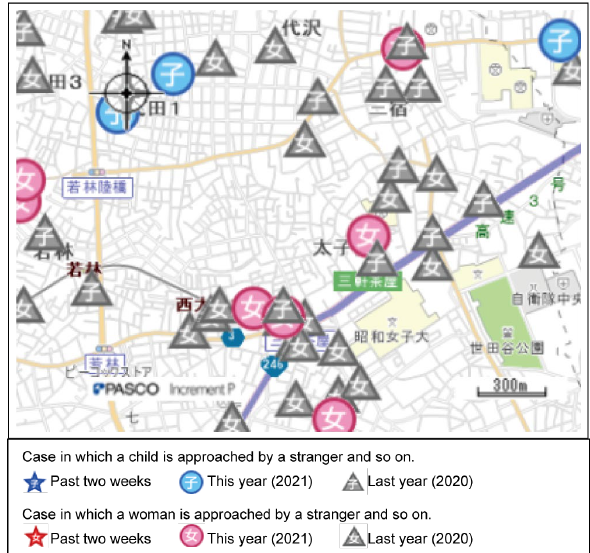
Figure 9. Spatial distribution of crime in the neighbourhood published in the Crime Information Map (Metropolitan Police Department,